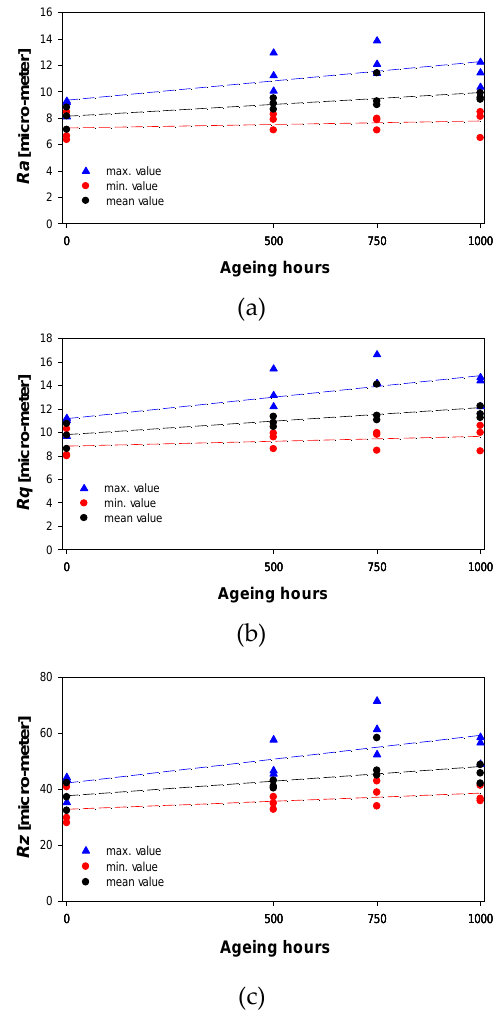
Figure 6. S-line connectors. Surface roughness measurements. Dashed lines are the tendency lines. ( a ) R a . ( b ) R q . ( c ) R z .